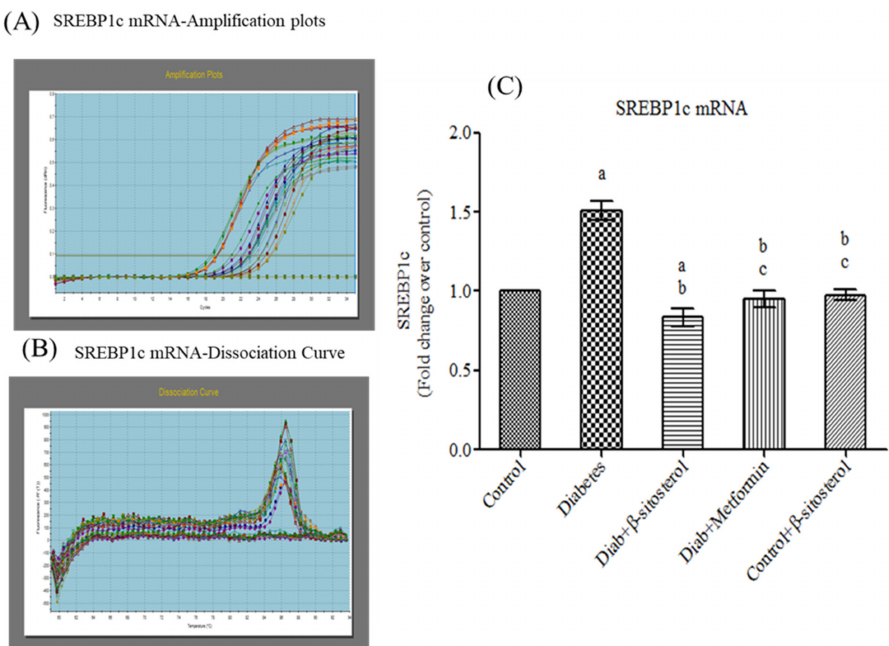
Figure 8. Effect of SIT on mRNA expression of SREBP-1c in adipose tissue of type-2 diabetic rats. The mRNA expression of SREBP-1c was assessed by real time-PCR. ( A ): Amplification plots; ( B ): dissociation curve analysis confirms the single product of SREBP-1c mRNA and ( C ): mRNA expression is given in fold change. Each bar represents mean ± SEM ( n = 6). Significance at p < 0.05. a Significantly different from the control group; b significantly different from the diabetic group; c significantly different from the β -sitosterol treated diabetic group.